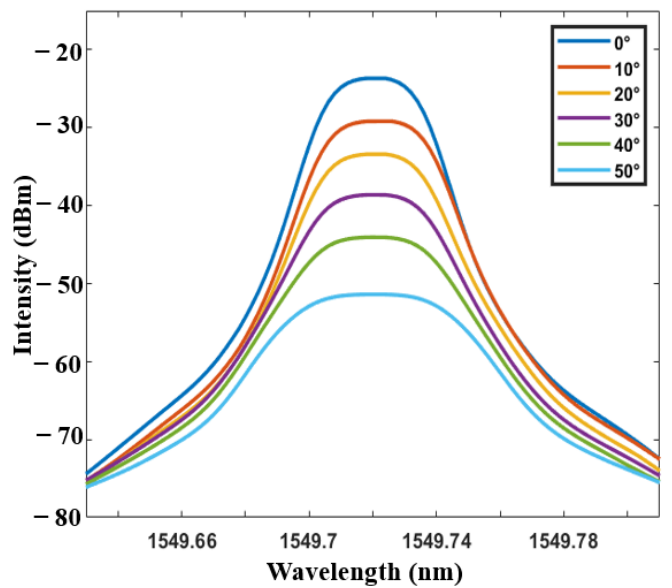
Figure 14. The dependence of the reflection spectrum at the wavelength of the reflection peak at different inclination angles in FRL with waist equals 75 µm.